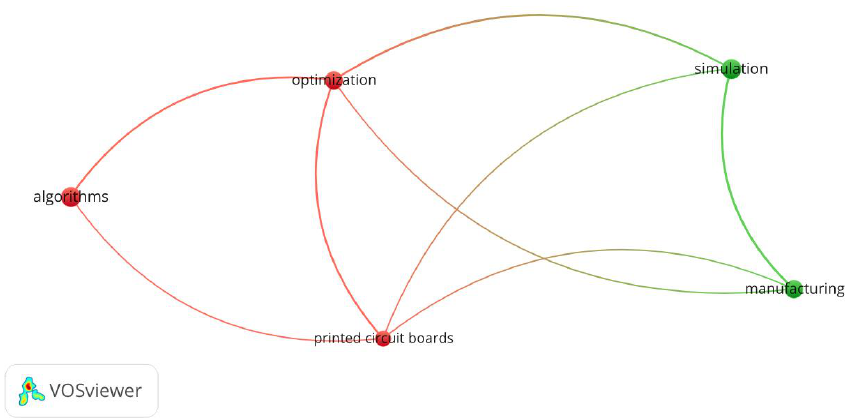
Figure 4. Publication keywords co-occurrence cluster during the 2000 – 2008 Phase .